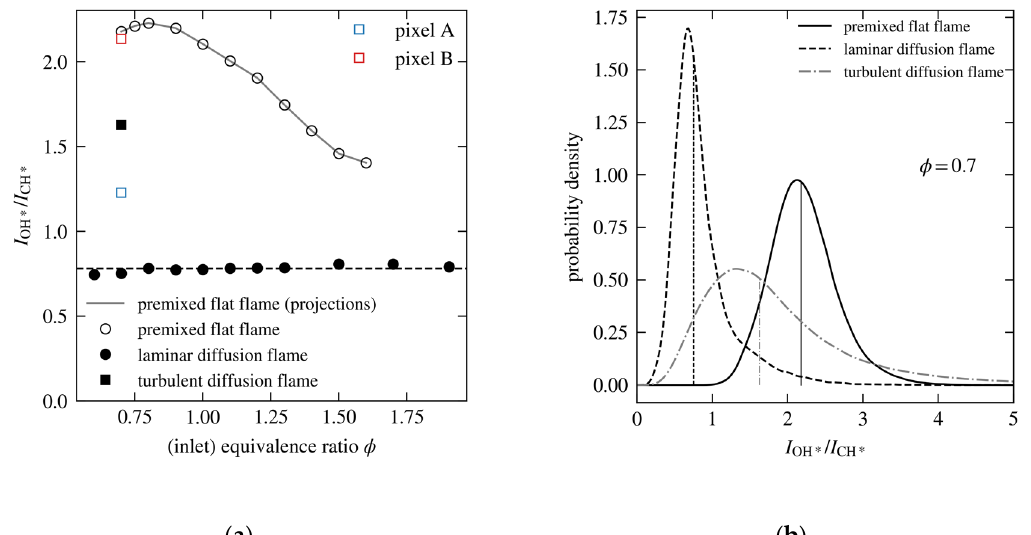
Figure 17. Evaluation of the intensity ratio I OH ∗ / I CH ∗ for a premixed flat flame as well as laminar and turbulent di ff usion flames (all methane / air): ( a ) Median intensity ratio as a function of (global) equivalence ratio. The gray solid line is the intensity ratio of the premixed flame obtained directly from the radon projections. Open squares represent median values of the turbulent flame for selected individual pixels (see text for more details). ( b ) Intensity ratio distribution at φ = 0.7 evaluated over all pixels of the reconstructed distributions. Vertical lines indicate the median intensity ratio. For di ff usion flames, the equivalency ratio refers to the fuel-air ratio between the separate input streams of methane and